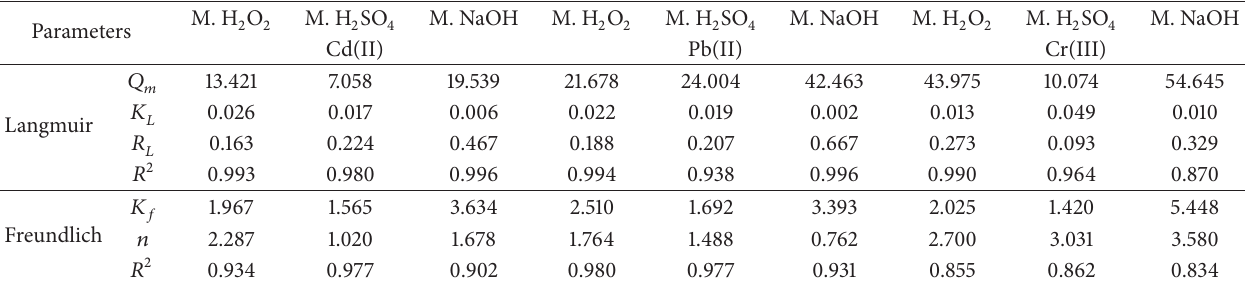
Table 8: Parameters related to the linear models for Langmuir and Freundlich adsorption of Cd(II), Pb(II), and Cr(III) by M. H 2 O 2 , M. H 2 SO 4 , and M. NaOH